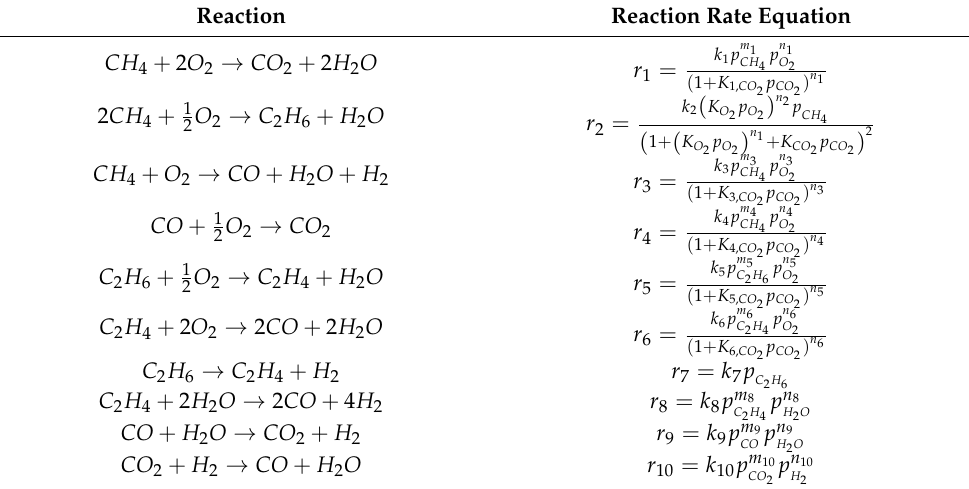
Table 4. Reaction steps considered in the kinetic model proposed by Stansch et al. [92] to describe OCM in the presence of a La 2 O 3 /CaO catalyst.